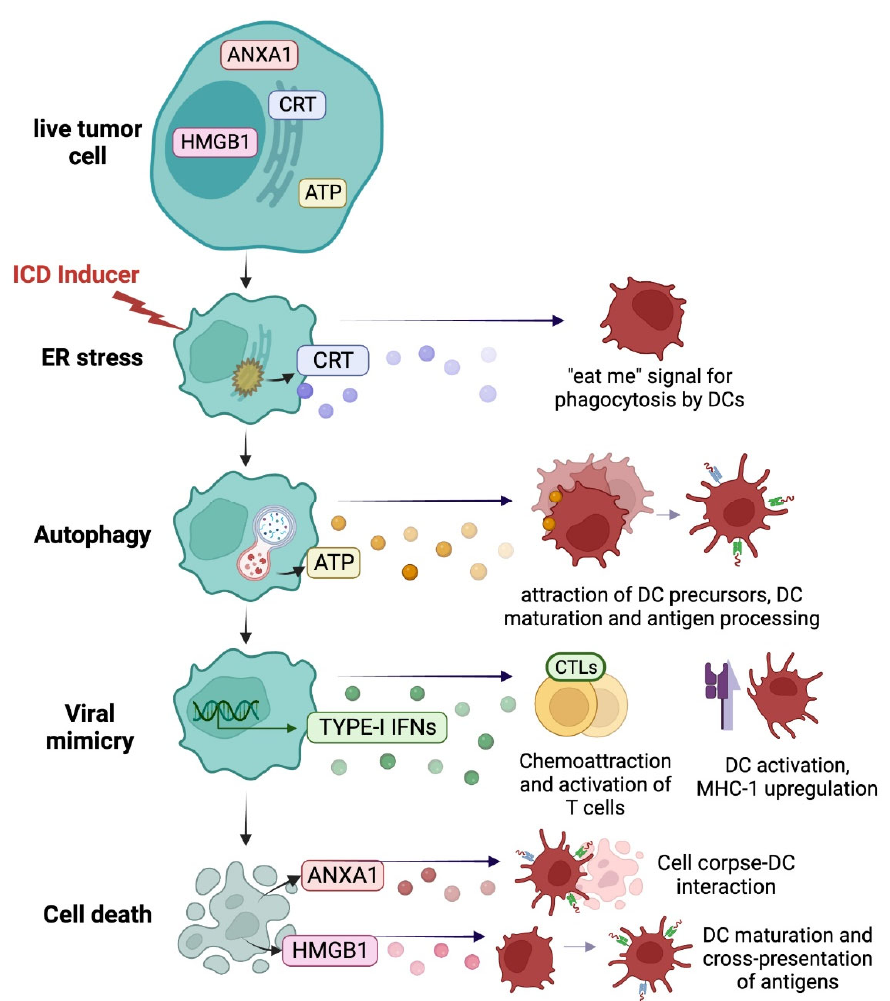
Figure 1. Immunogenic DAMPs from dying cancer cells. ICD inducers stimulate a series of stress and death pathways in malignant cells, which leads to the exposure of immunogenic DAMPs. In response to ER stress, cells translocate intracellular CRT to the cell surface where it acts as a potent “eat me” signal, promoting cell engulfment and phagocytic clearance by DCs. The release of